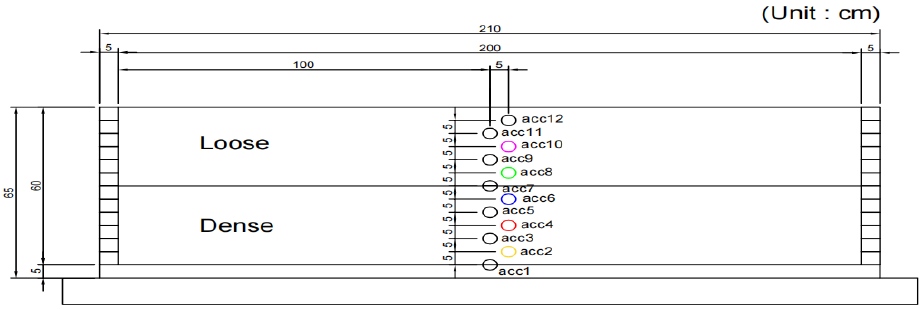
Figure 4. The cross-section and accelerometer location of the flat ground.